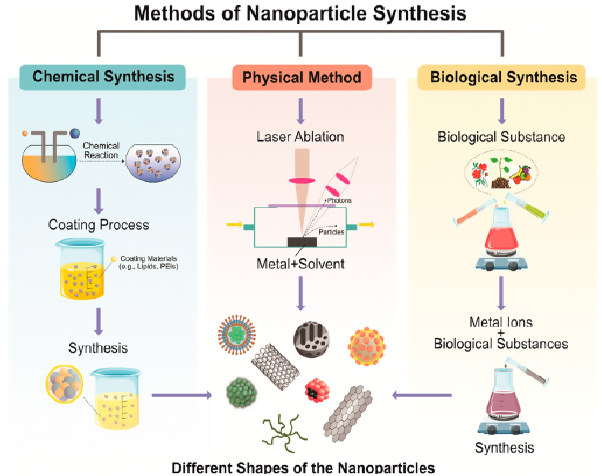
Figure 2. Classical methods of nanoparticle synthesis. Reproduced from MDPI [51].